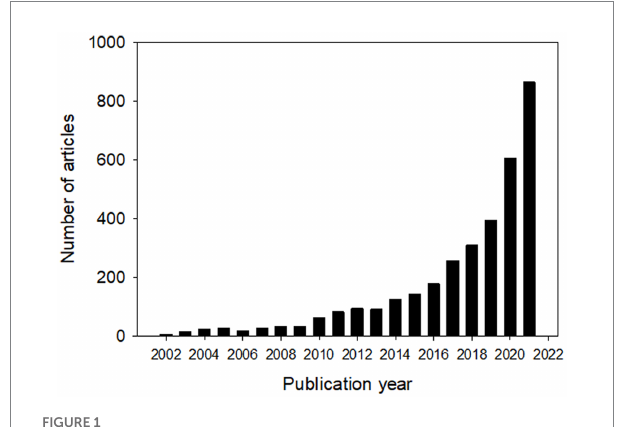
FIGURE 1 Number of publications on sustainable food packaging between 2002 and July